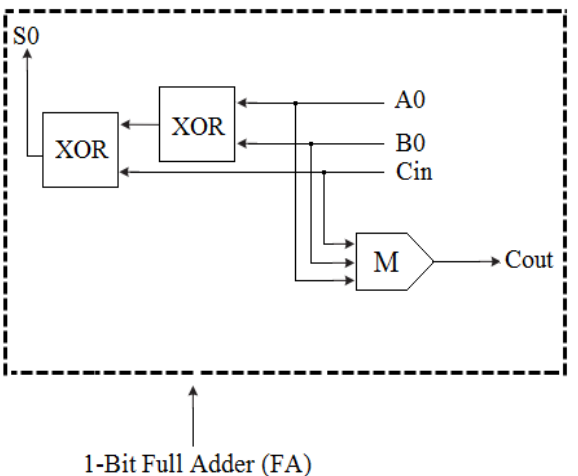
Figure 4. Schematic logic diagram of the novel FA circuits.